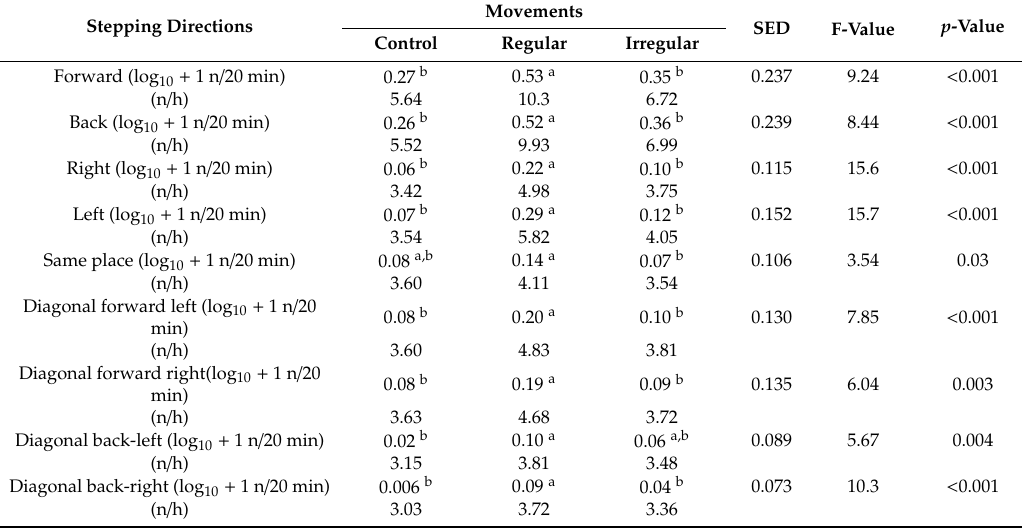
Table A1. E ff ects of motion type on total stepping directions of sheep ( n = 6) during simulated sea conditions.